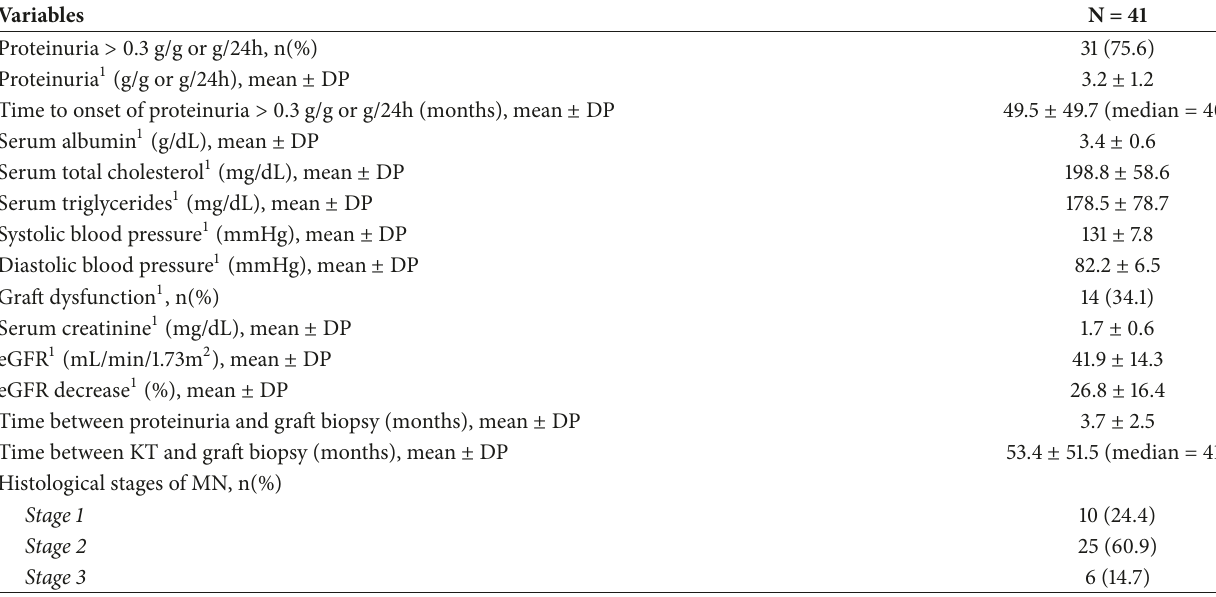
Table 2: Clinical presentation of patients with posttransplant MN.